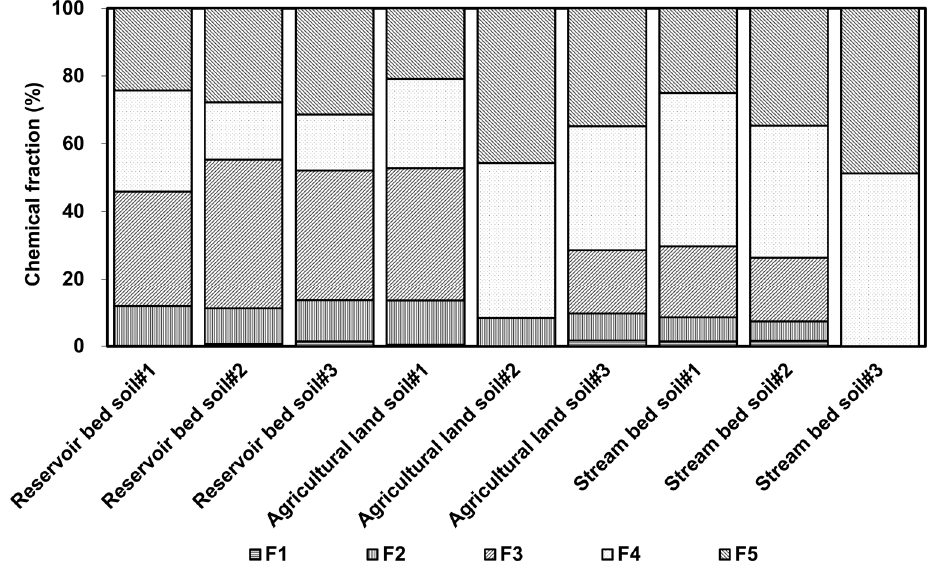
Figure 5. Distribution ratio of arsenic in soil as determined by continuous extraction (“F” means form